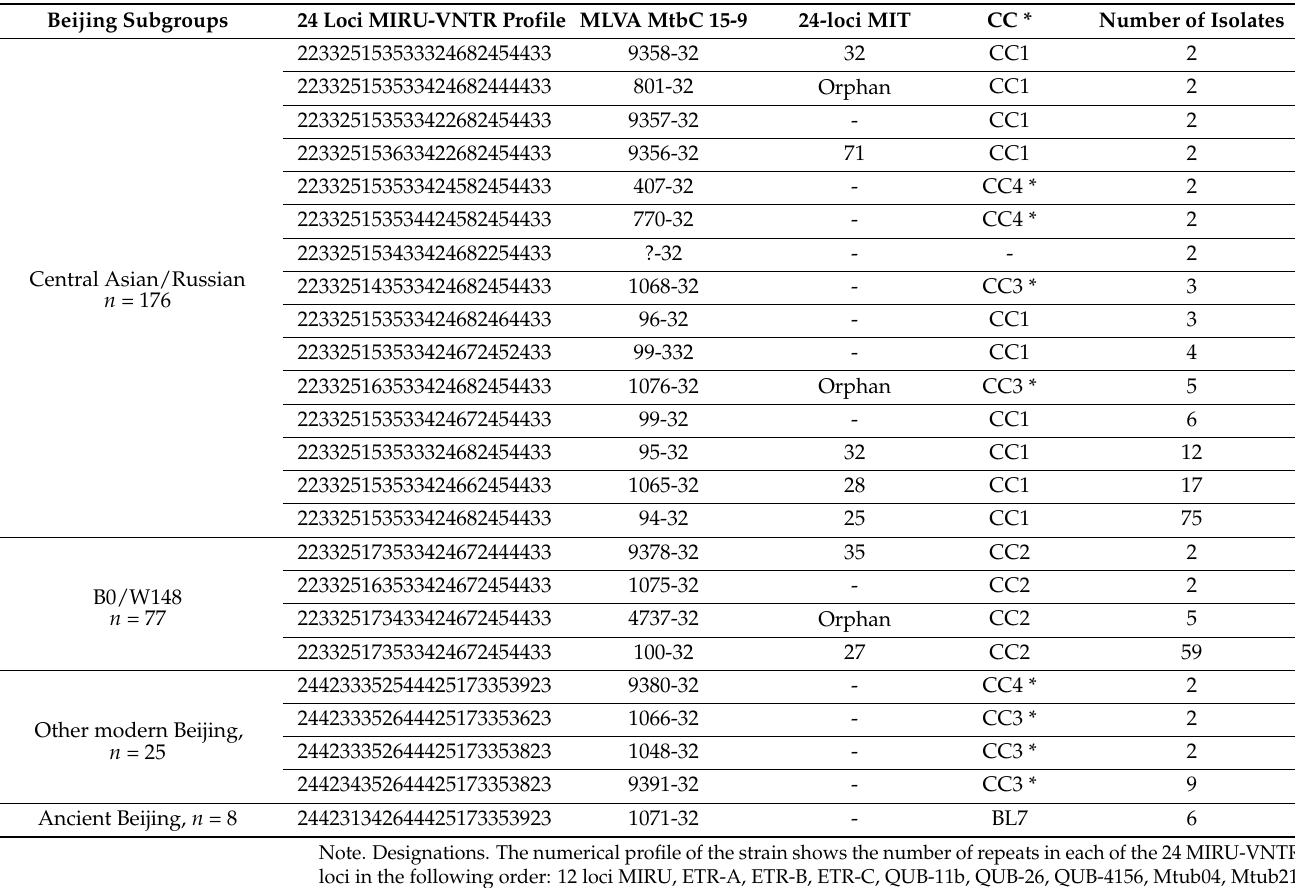
Table 3. 24-MIRU-VNTR shared types (2 isolates and more) of main genotype groups.